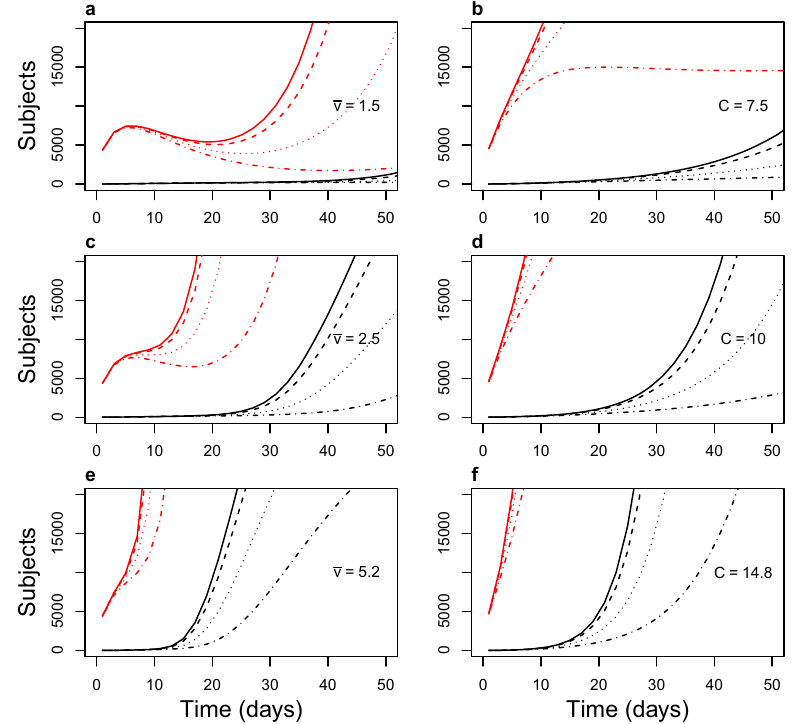
Fig. 4 Successful/unsuccessful suppression in the fi rst 50 days. Detail of Fig. 3. Density-dependent contact rate simulations on the left ( a , c , e ); fi xed contact rate simulations on the right ( b , d , f ). Suppression is achieved in the most optimistic scenario (contact rate 7.5, app users 75%) with fi xed contact rate ( b ), whereas its success varies from district to district in scenarios with density-dependent contact rate.